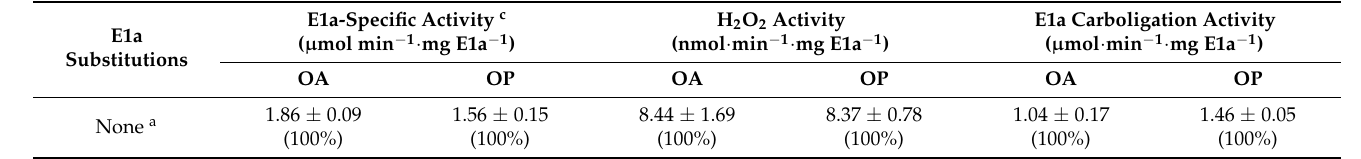
Table 2. Activities of the E1a substituted variants in different assay